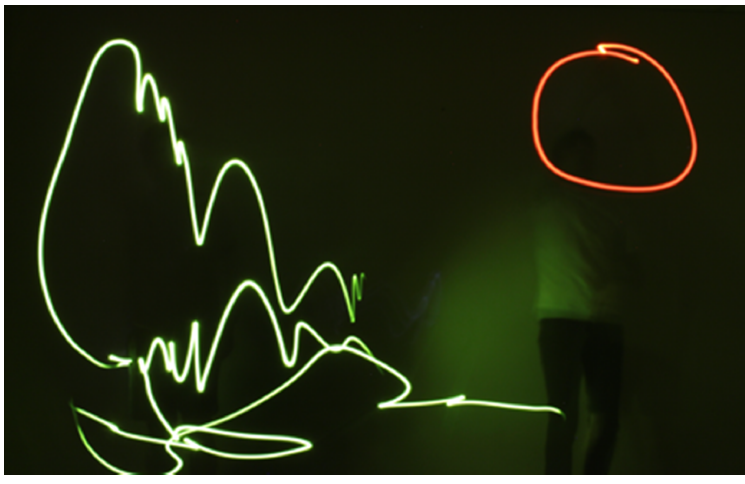
Figure 1. Collaborative gesture-based painting.